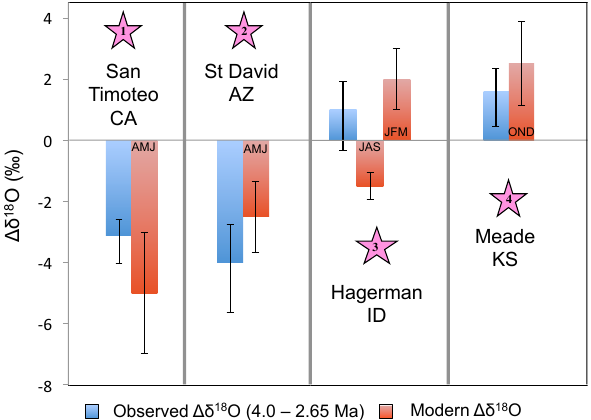
Fig. 5. Comparison of observed Pliocene 1δ 18 O with modern El Ni˜no δ 18 O anomalies. Error bars in observed 1δ 18 O values show 95% confidence intervals in differences between relevant sample bins. Error bars in modern El Ni˜no anomalies show 95% confidence intervals from calculated kriging prediction errors. Numbered stars correspond to labeling in Fig.